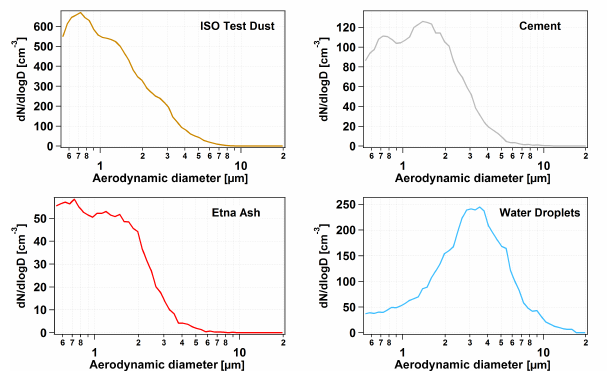
Figure 5. Typical number size distributions of the different aerosol types as a function of the aerodynamic particle diameter measured with an